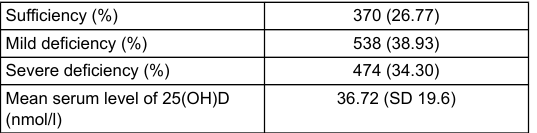
Table 2: Distribution of vitamin D status among the 1382 patients with vitamin D testing (total = 1382).